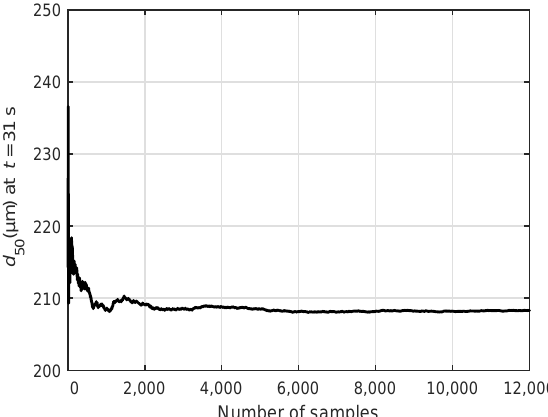
Figure 1. Stability of the Monte Carlo methods with respect to the number of samples drawn. The mean value for the d 50 stabilizes after around 5000–6000